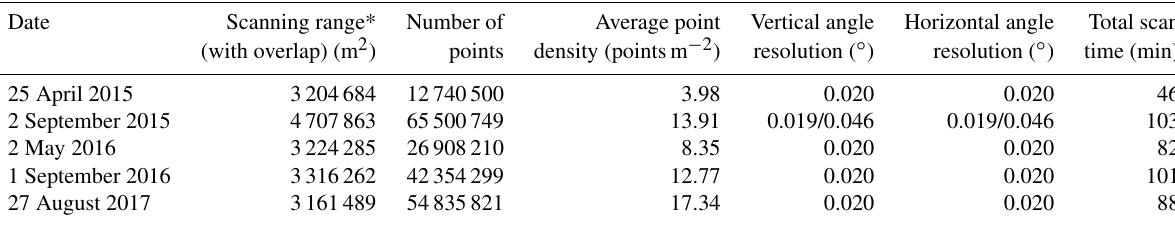
Table 1. Riegl VZ ® -6000 TLS surveying parameters of Urumqi Glacier No.